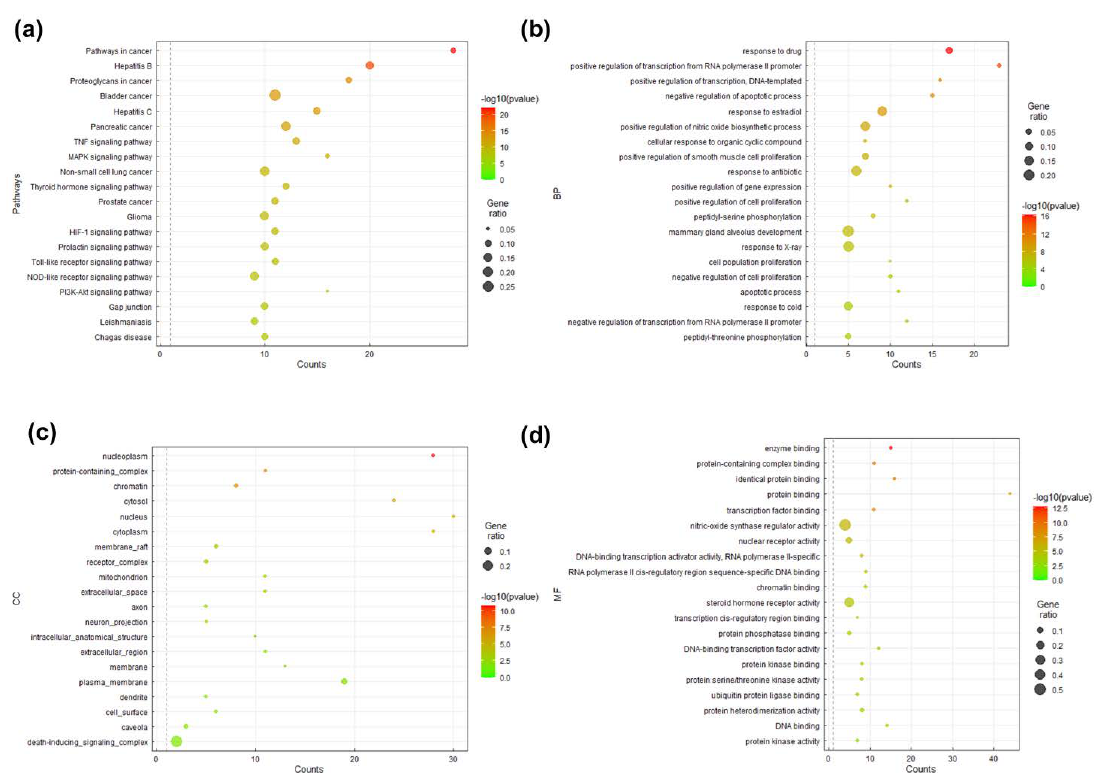
Figure 3. ( a ) Gene enrichment analysis in the KEGG Pathway. GO enrichment analysis of biological processes ( b ), cellular components ( c ), molecular functions, and ( d ) key targets of SCH. The X -axis shows numbers of genes annotated in each pathway/GO. Sizes of circles represent gene ratios (defined as the number of annotated genes divided by the total number of genes in a given pathway/GO). Table 3. Top 20 KEGG pathways enriched with 47 key targets of SCH, as determined using the DAVID database. Pathway